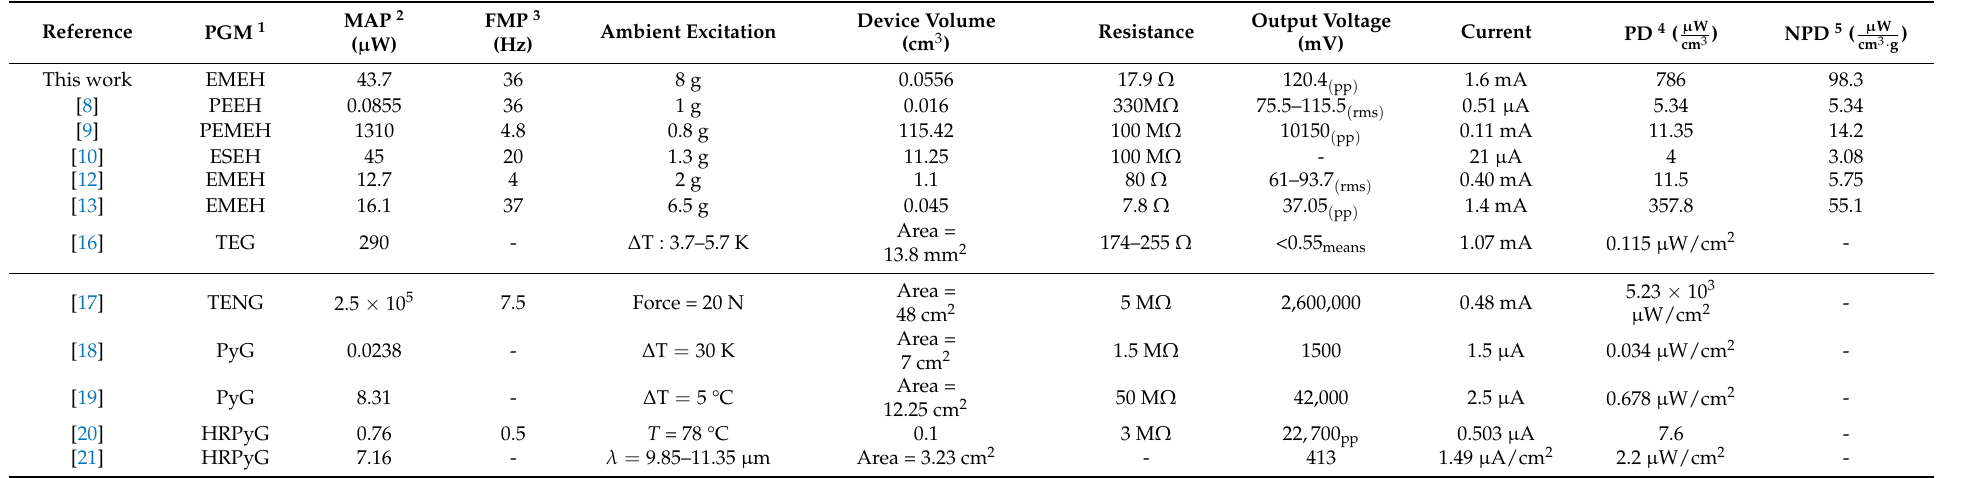
Table 3. Power performance comparison with some recently published energy